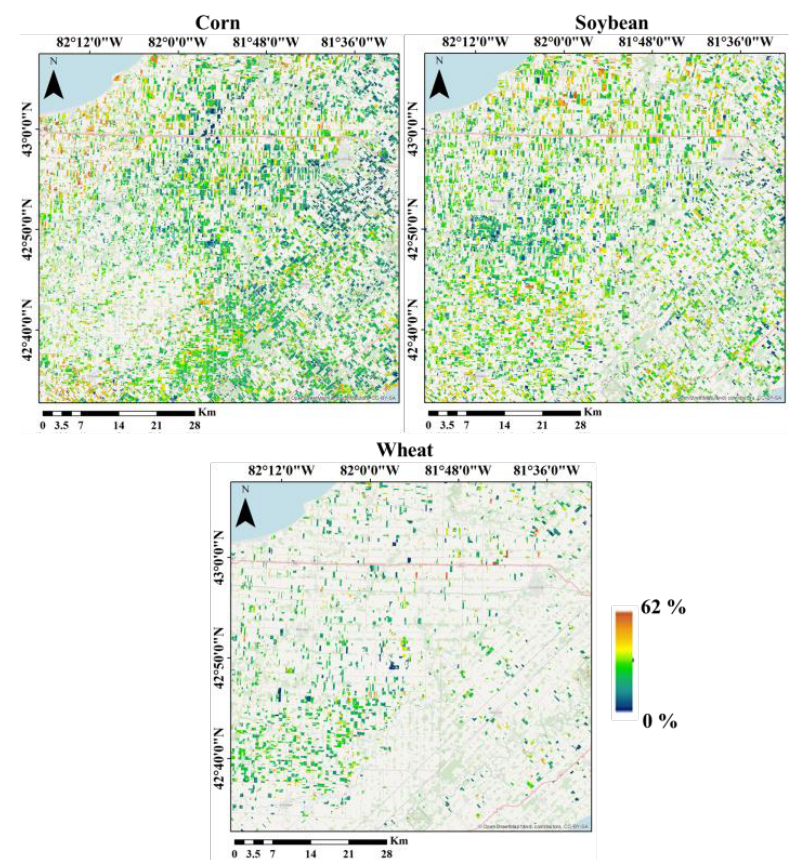
Figure 5. R 2 and RMSE between the actual and modeled RCF based on the fusion strategy at the decision level for corn, wheat and soybean crops. ORCF: observed residual cover fraction; MRCF: modeled residual cover fraction.